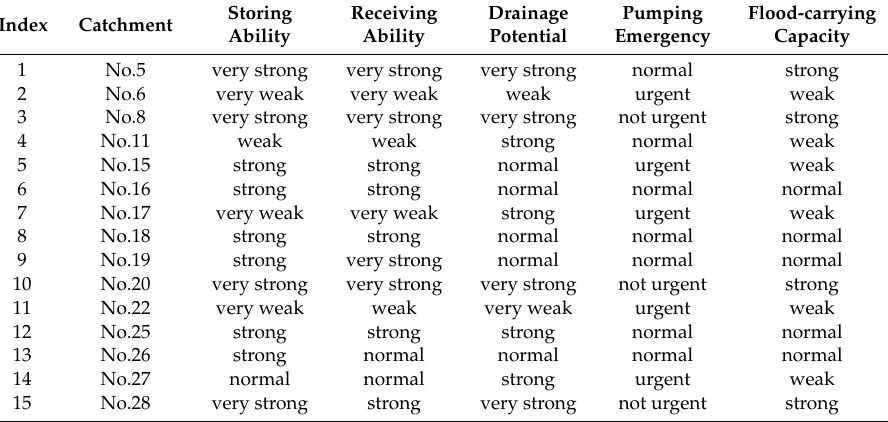
Table 7. Urban flood-carrying capacity assessment in the study area.